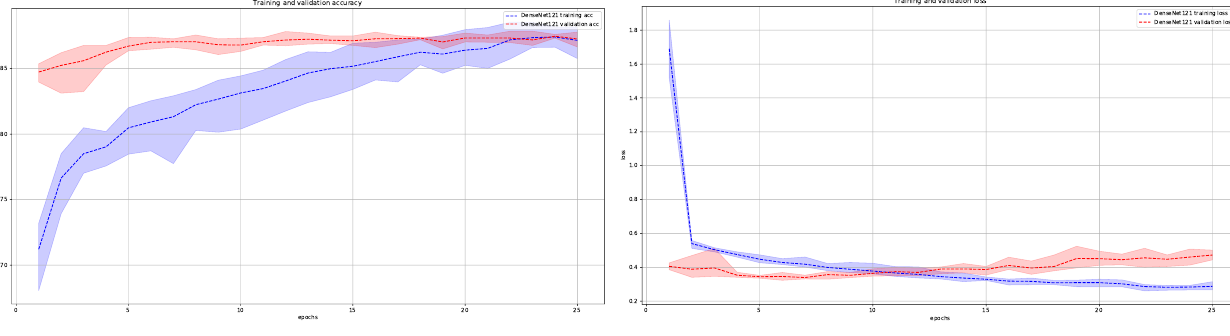
Figure 6. Average training and validation accuracy ( left ) and loss ( right ) during training of DenseNet121 for five times with maximal and minimal deviation areas marked in color (blue for training and red for validation).